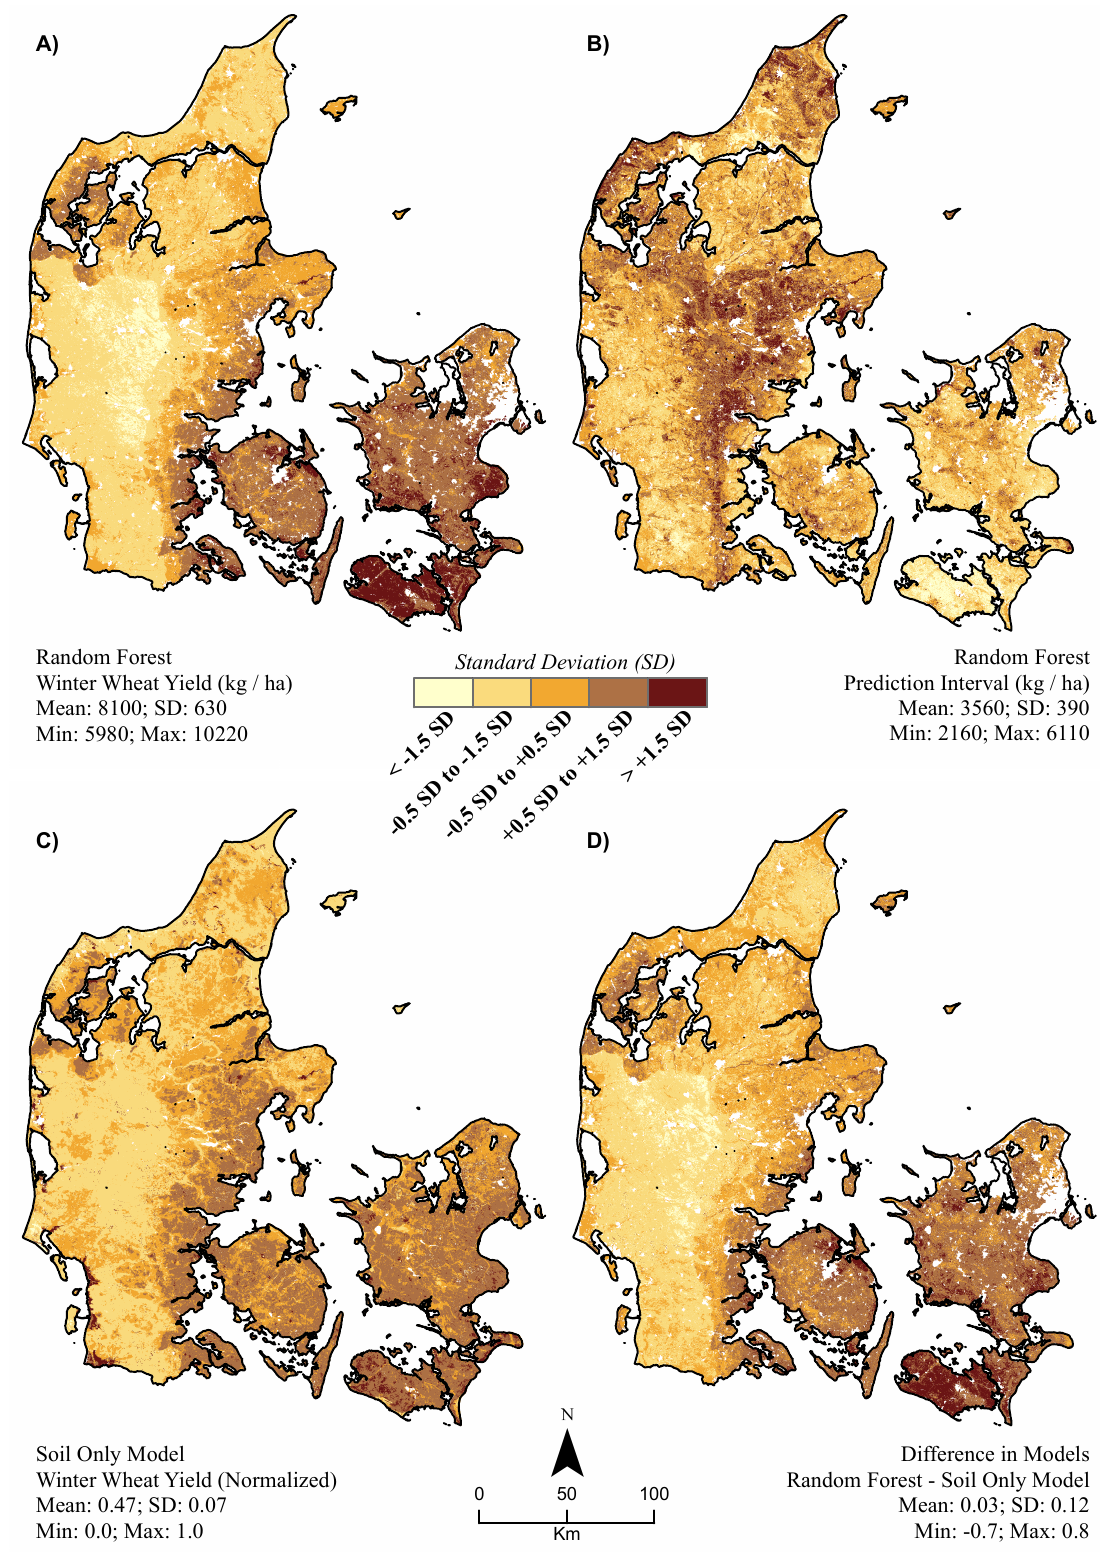
Figure 4. ( A ) Yield map of winter wheat produced from random forest model. ( B ) Prediction interval (quantiles 0.9–0.1) of random forest model. ( C ) Yield map from soil-only model. ( D ) Comparison between the two models (random forest–soil-only